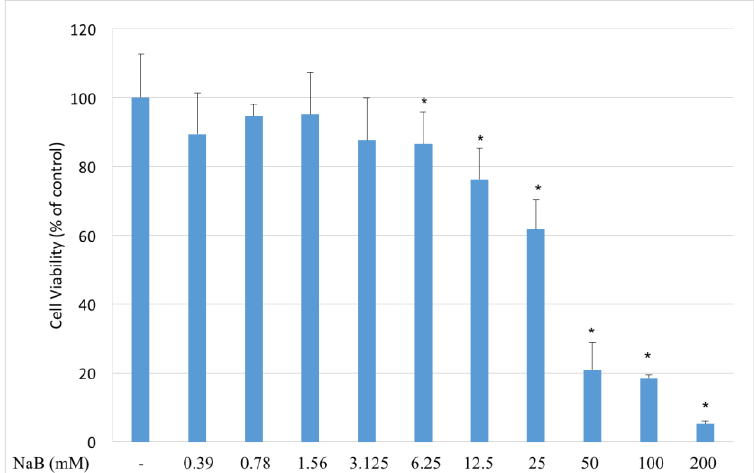
Figure 1. Modulation of HCT116 cell viability by NaB. HCT116 colon cancer cells were seeded to 96 well plates and after one night incubation, they were incubated with 0.39–200 mM concentrations of NaB for 24 h, before detecting cell viability with a MTT test. NaB inhibited cell viability between